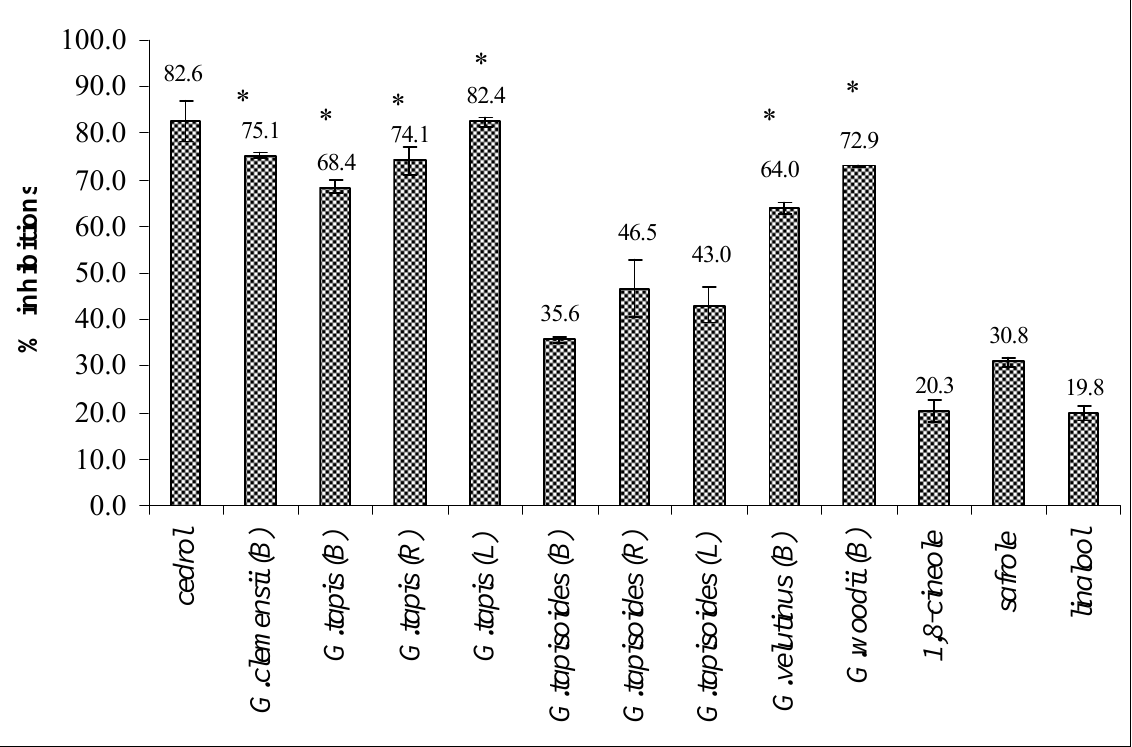
Table 5. IC values (µg/mL) of the oils and cedrol on PAF receptor binding to rabbit platelets. 50 Oils